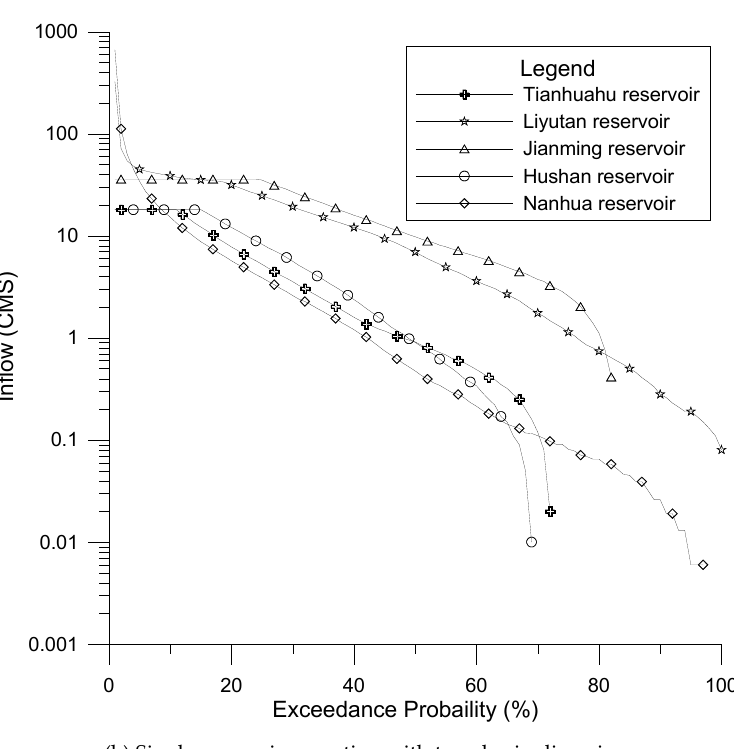
Figure 6. The net inflow duration curve of each selected reservoir case.